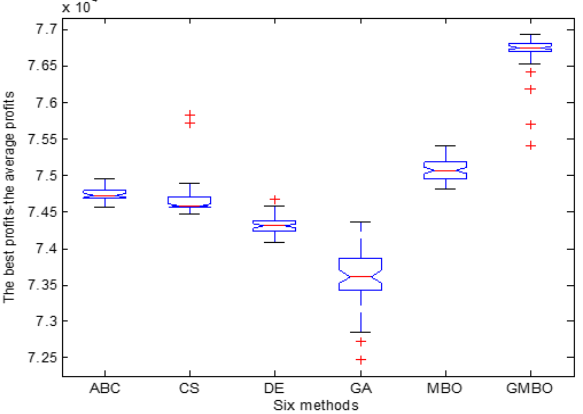
Figure 13. Boxplot of the best values on KP4 in 50 runs.